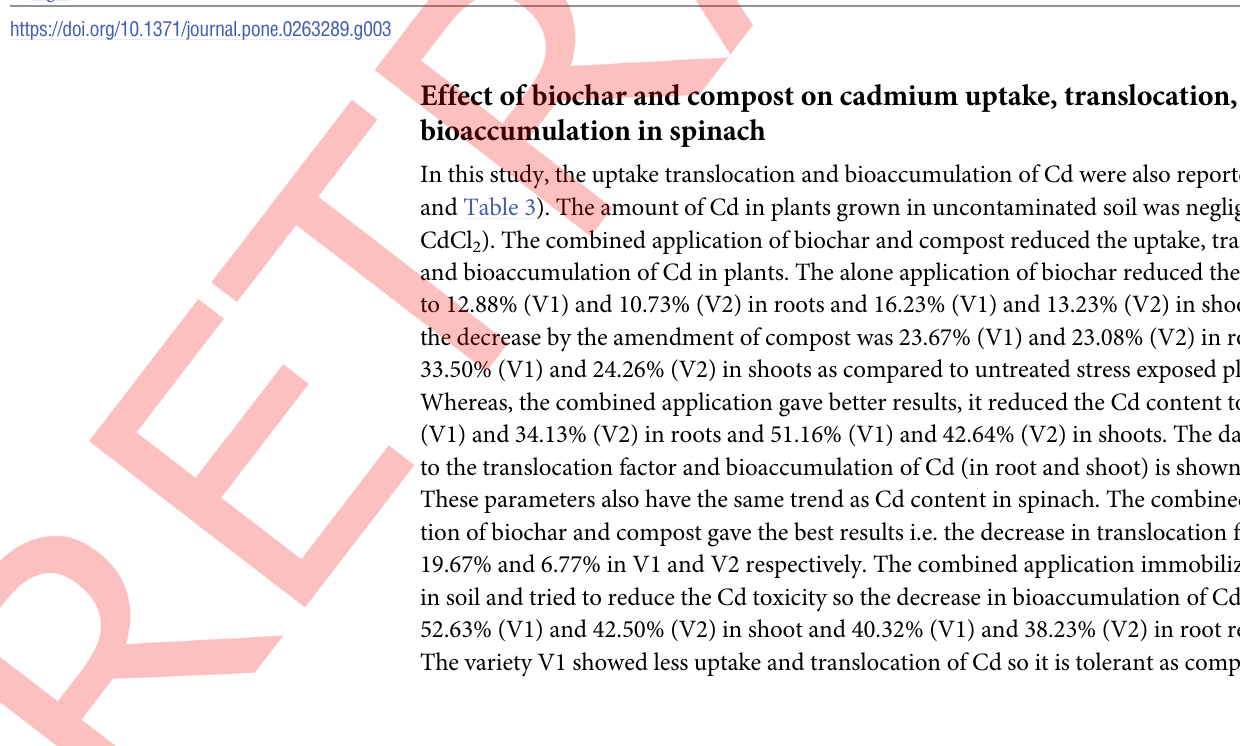
Fig 3. Effect of biochar and compost on antioxidant activities of Spinach under cadmium stress. (A) superoxide dismutase (B) peroxidase (C) catalase activities of Spinach. The mean of three replicates and standard deviation are presented. Different letters show the significant difference among treatments. Treatments as mentioned in Fig